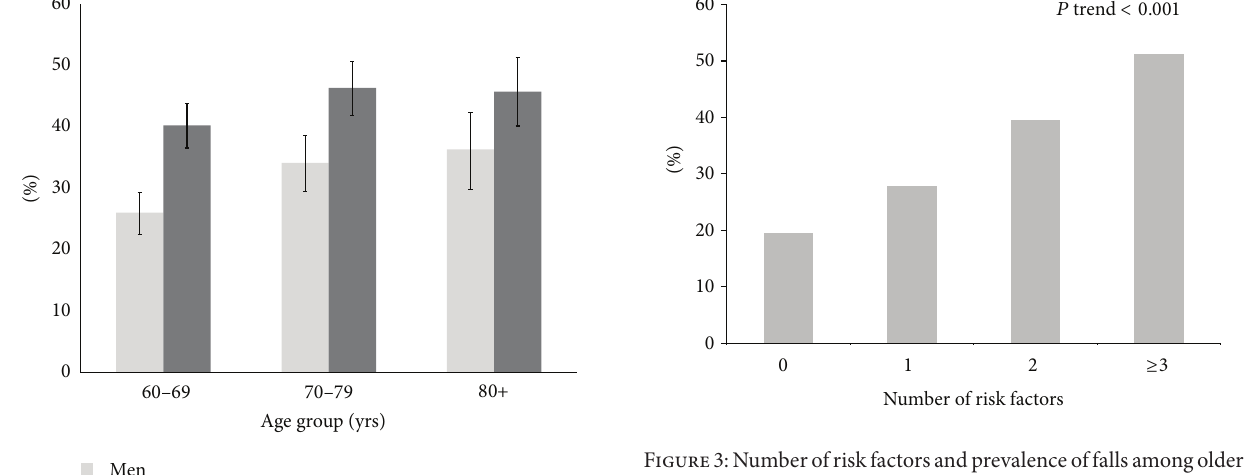
Figure3:Numberofriskfactorsandprevalenceoffallsamongolder adults in